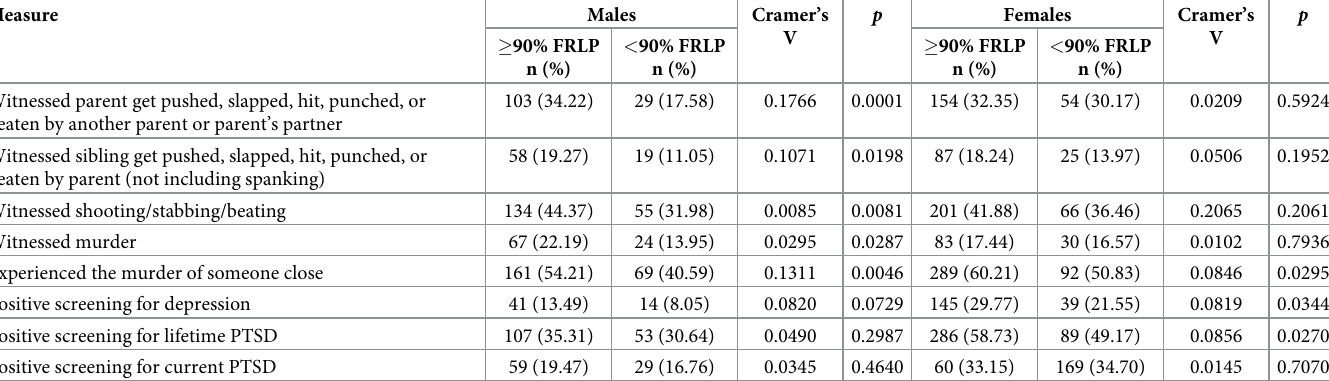
Table 4. Indirect exposure to violence and adverse mental health symptomatology among males and females, by percentage of student free/reduced lunch participa- tion (FRLP) of attended school (N = 1548). Measure